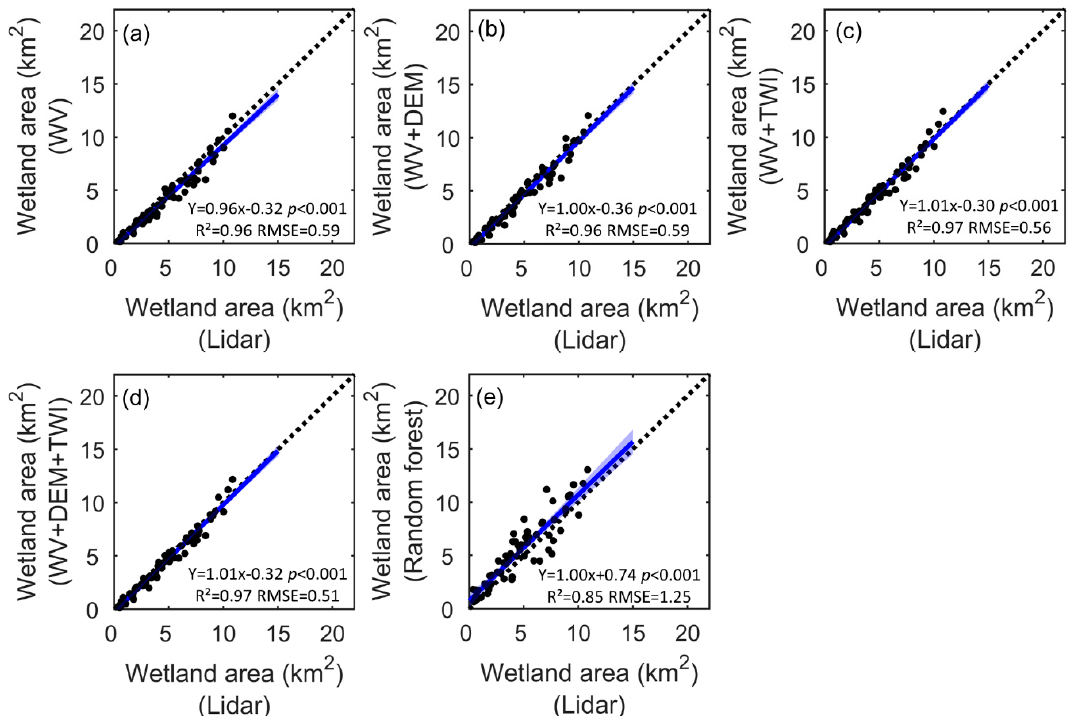
Figure 8. Comparisons of wetland areas predicted by deep learning algorithms ( a – d ) in our study and random forest ( e ) against the lidar intensity-derived inundation labels. Each black point represents the estimate of wetland area in each image out of the 64 image patches. The black dashed line is the 1:1 line. The blue line is the linear regression model. The blue shadow shows the 95% confidence interval of the linear regression model. WV3: WorldView-3, DEM: Digital Elevation Model, TWI: Topographic Wetness Index, RMSE: Root Mean Square Error.